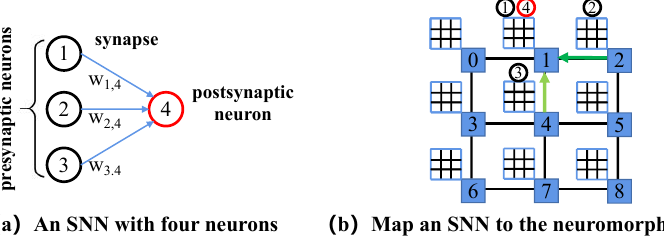
Figure 2. Map of an SNN to the neuromorphic hardware. ( a ) An SNN with three presynaptic neurons connected to a postsynaptic neuron. ( b ) A neuromorphic hardware has nine cores interconnected by the NoC.